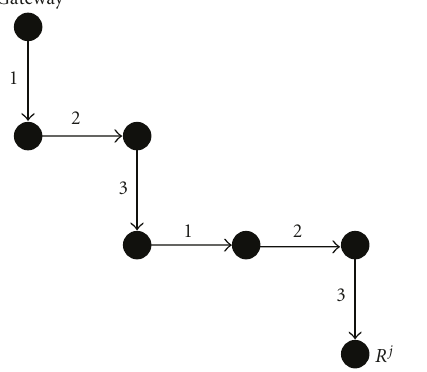
Figure 5: A TDMA scheduling scheme in backbone communica- tions with SRD = 3.